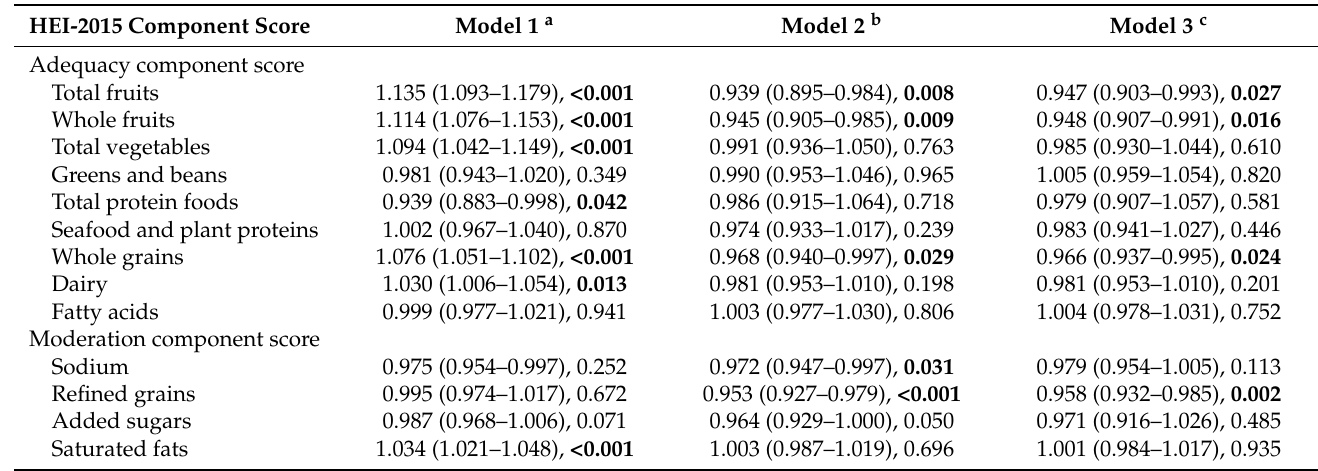
Table 4. Associations of HEI-2015 components with cataract.